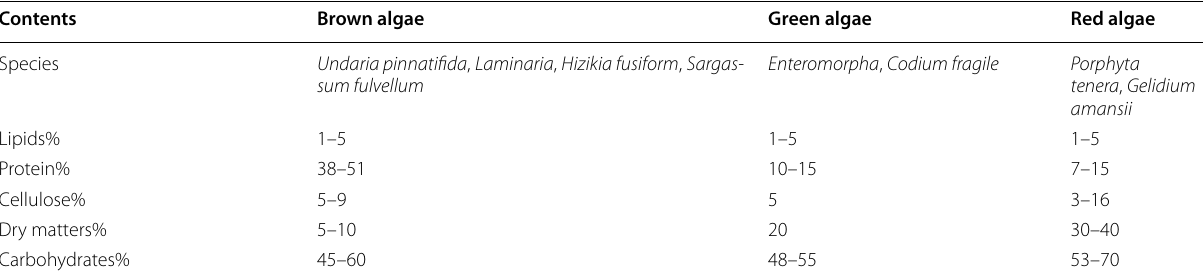
Table 1 Different constituents of marine algae (Kim et al.